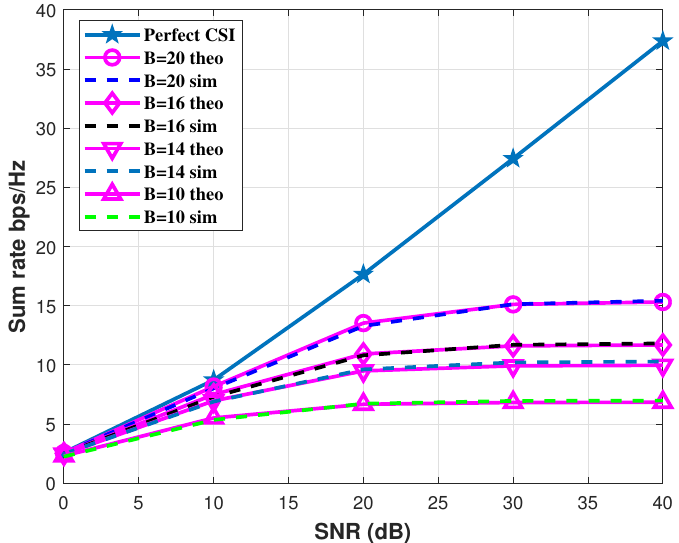
Figure 4. Performance comparison of theoretical and simulation results with RVQ-based CSI feedback with different quantization bits in ( 2 × 2,1 ) 3.